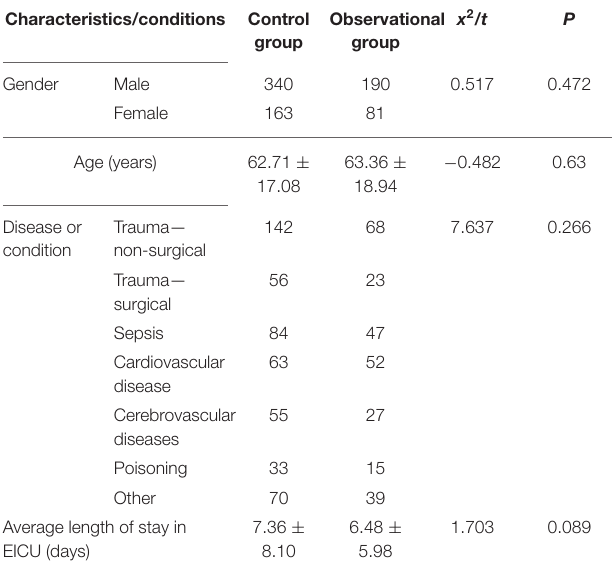
TABLE 1 | Patient demographics and their conditions requiring treatment in the EICU ( n = 774). Characteristics/conditions Control